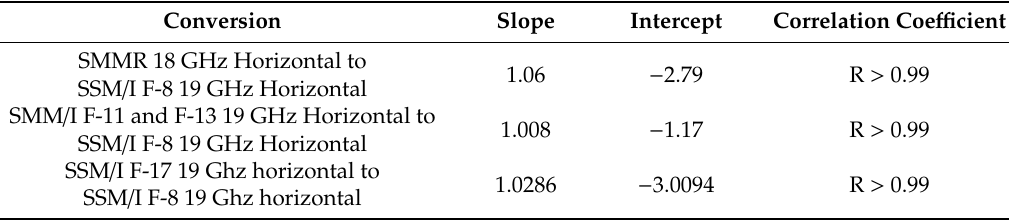
Table 1. Regression coe ffi cients for data adjustments between di ff erent